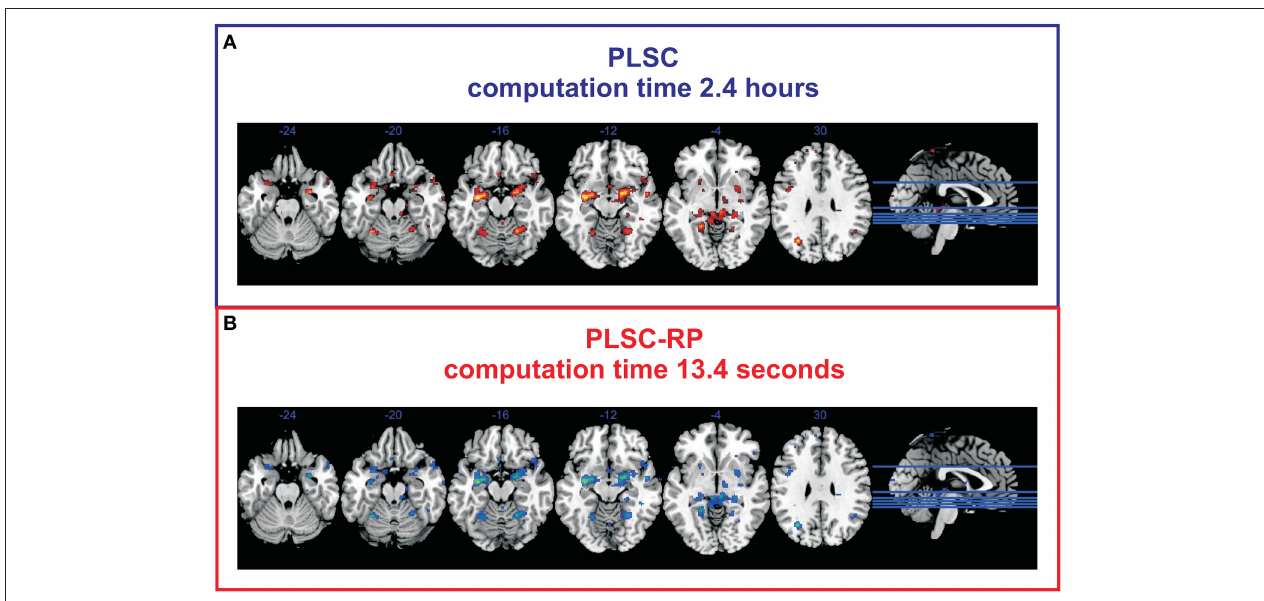
FIGURE 2 | Voxels associated to the SNPs rs10014254, rs11722038, and rs17529323 during fMRI face-matching task. (A) Voxel weight profile of PLSC considering whole-brain. (B) Voxel weight profile of PLSC-RP after dimensionality reduction of the fMRI data set to 208 dimensions. Only voxels with top 50% weights are shown. We found an association with fMRI activity in bilateral amygdala ( x = − 22 , y = − 4 , z = − 12 ; x = 18 , y = − 4 , z = − 12 ), bilateral cerebellum ( x = − 28 , y = − 54 , z = − 20 ; x = 22 , y = − 54 , z = − 16 ), left hippocampus ( x = − 32 , y = − 10 , z = − 14 ), left lingual gyrus ( x = − 20 , y = − 46 , z = − 4 ), right putamen ( x = 28 ,